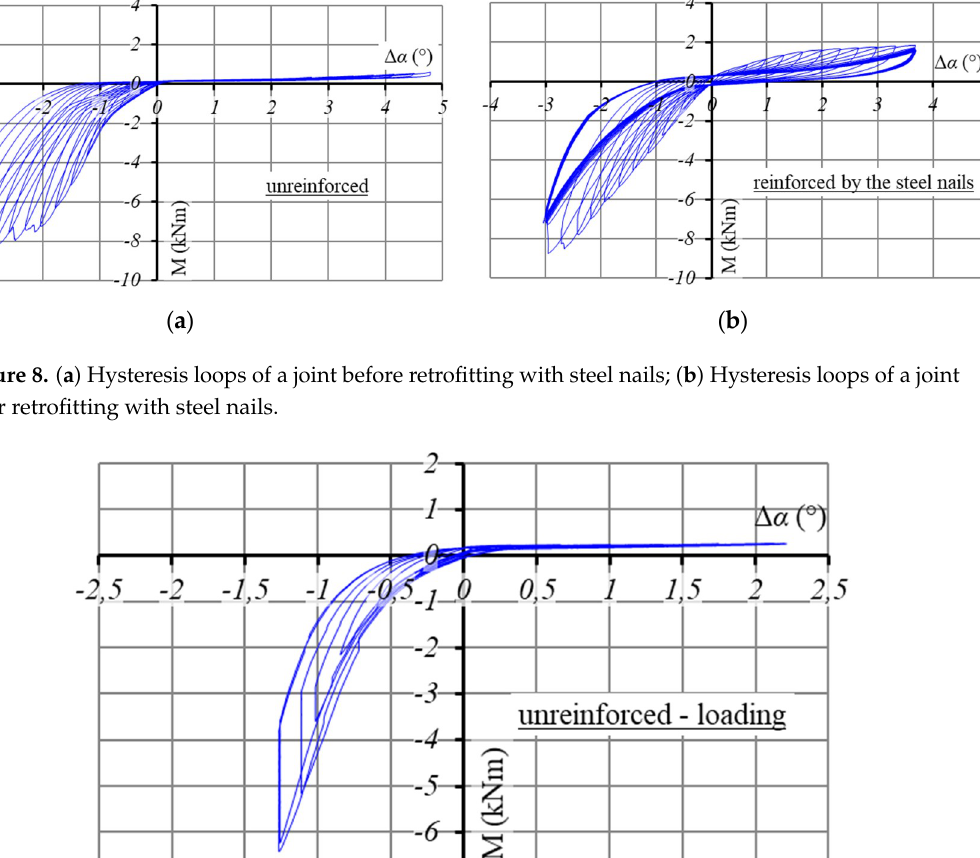
Figure 10. Hysteresis loops of a joint retrofitted with brake plates.